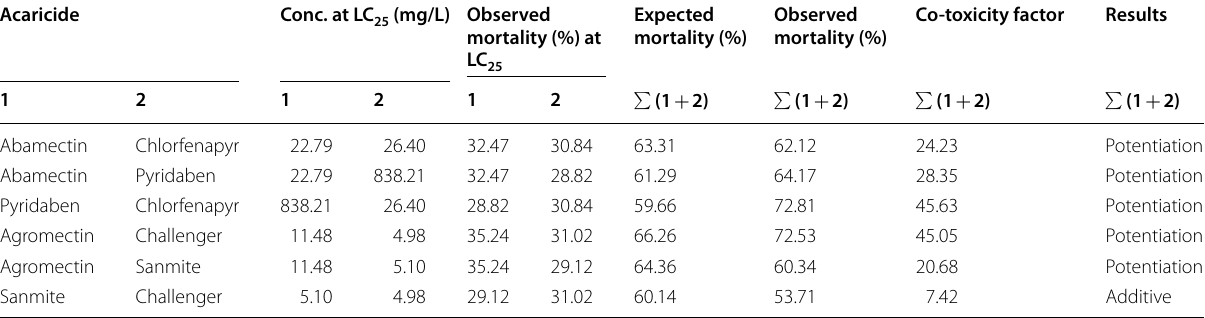
Table 4 Joint toxic effect of technical (abamectin, chlorfenapyr, and pyridaben) and formulated (Agromectin, Challenger, and Sanmite) mixtures at LC values of each acaricide against eggs of T. urticae by leaf-disk-dip technique 25